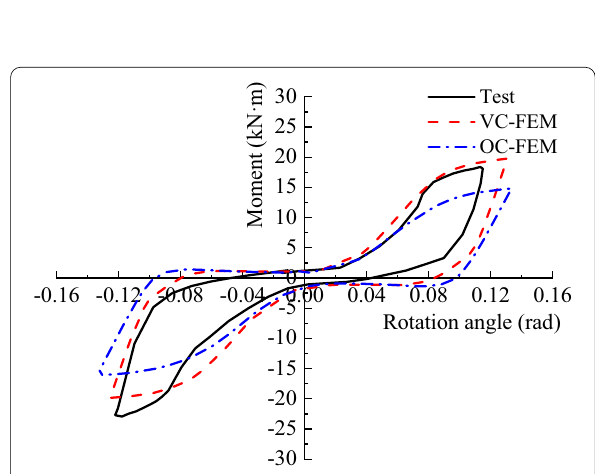
-0.16 -0.12 -0.08 -0.04 0.00 0.04 0.08 0.12 0.16